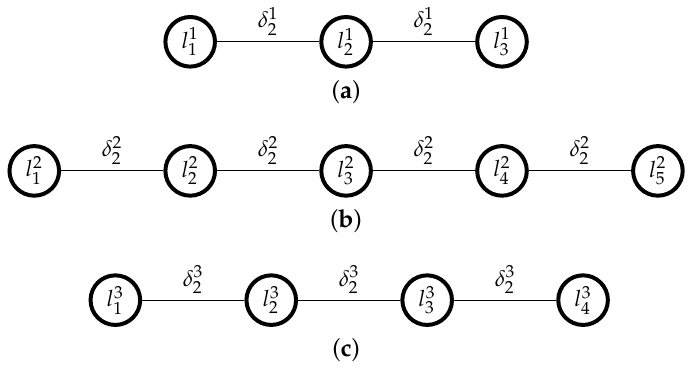
Figure 1. OPMs. Uniform case. ( a ) Metrizable OPM associated with the proximity matrix A 22 ; ( b ) Metrizable OPM associated with the proximity matrix A 2222 ; ( c ) Metrizable OPM associated with the proximity matrix A 222 .